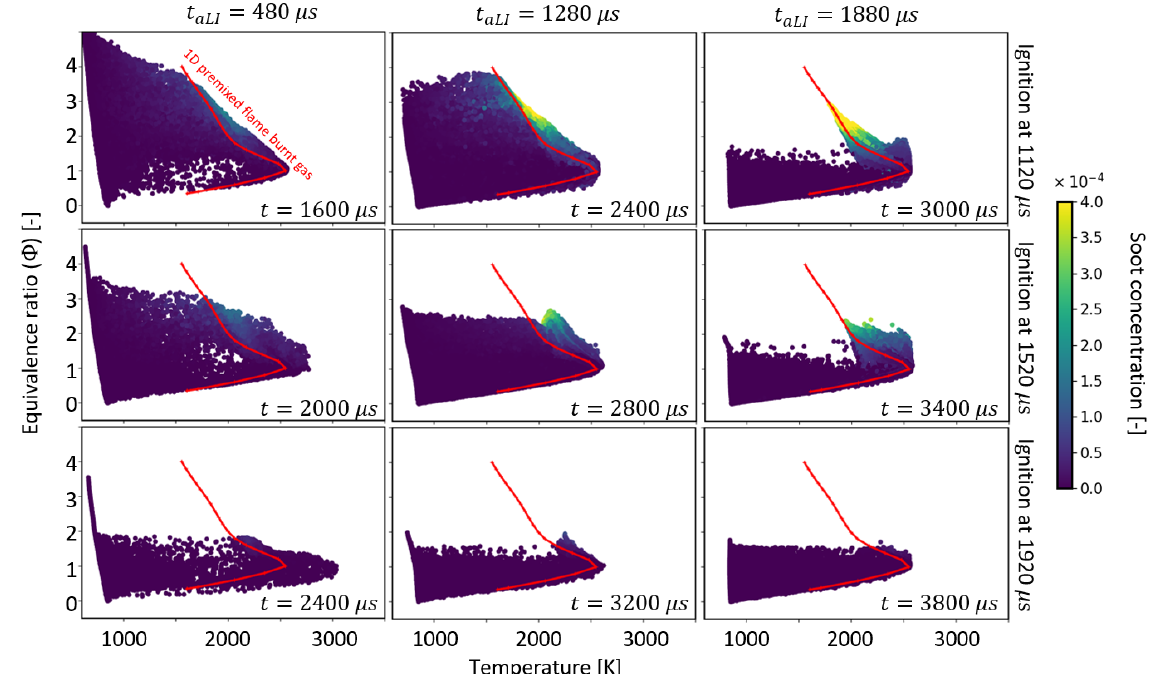
Figure 11. Scatter plot of equivalence ratio (passive scalar) as a function of temperature at different times after laser ignition ( t aLI ) for the three laser ignition timings. The points are colored by the soot concentration (soot mass/total mass). The red curve shows the burnt gas temperature from 1D premixed flame